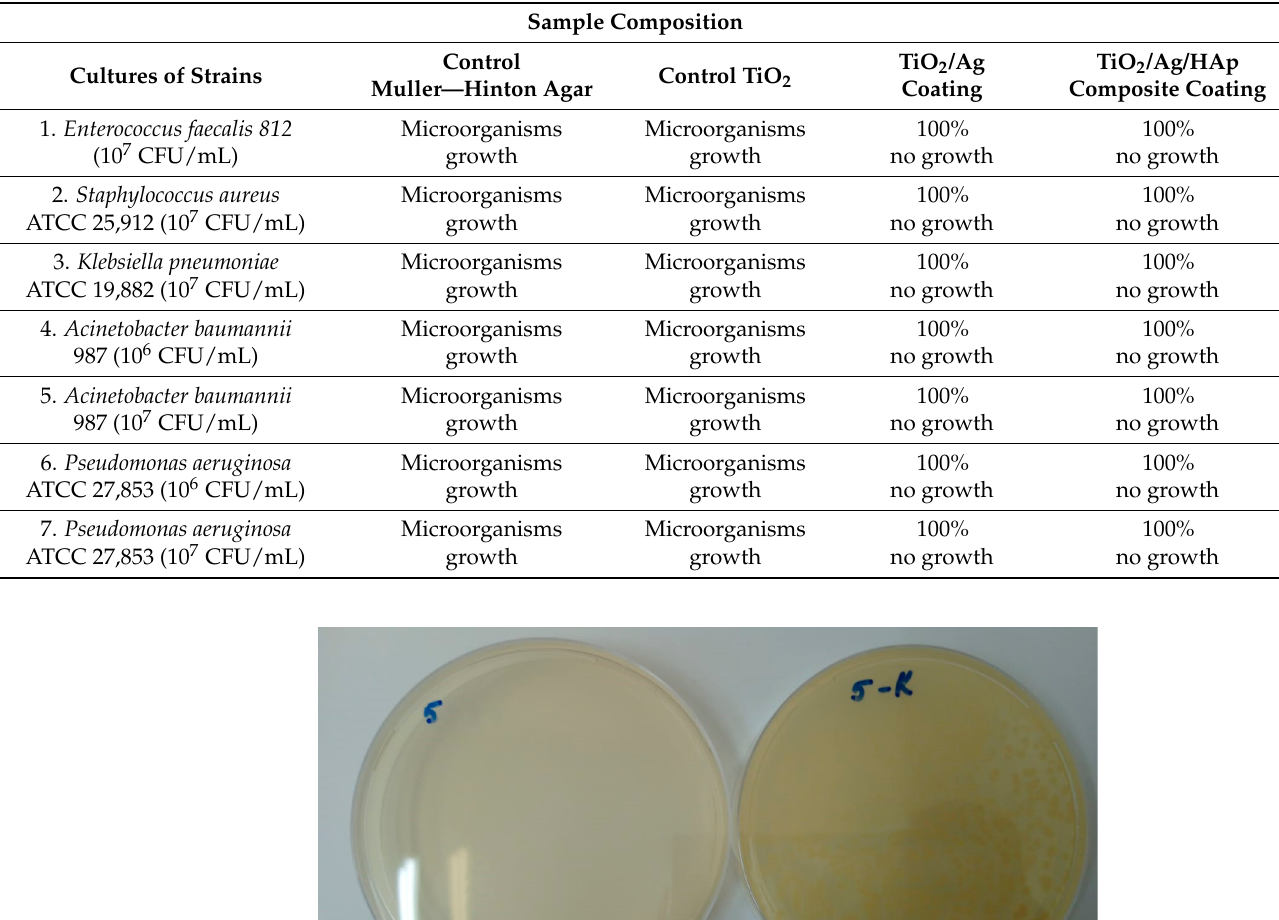
Table 2. Studies of the antibacterial activity of TiO 2 /Ag/HAp composite coating.